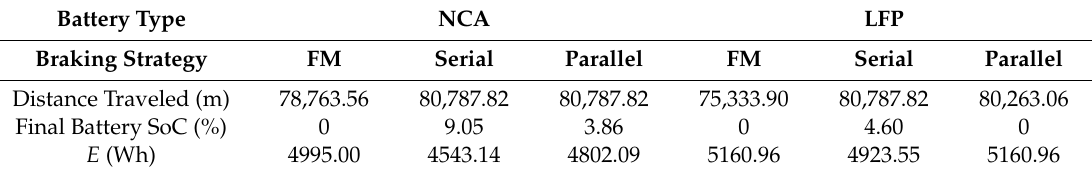
Table 5. Non-RE cases result in the complete route.